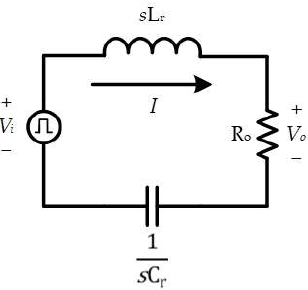
Figure 11. RLC series resonant circuit.